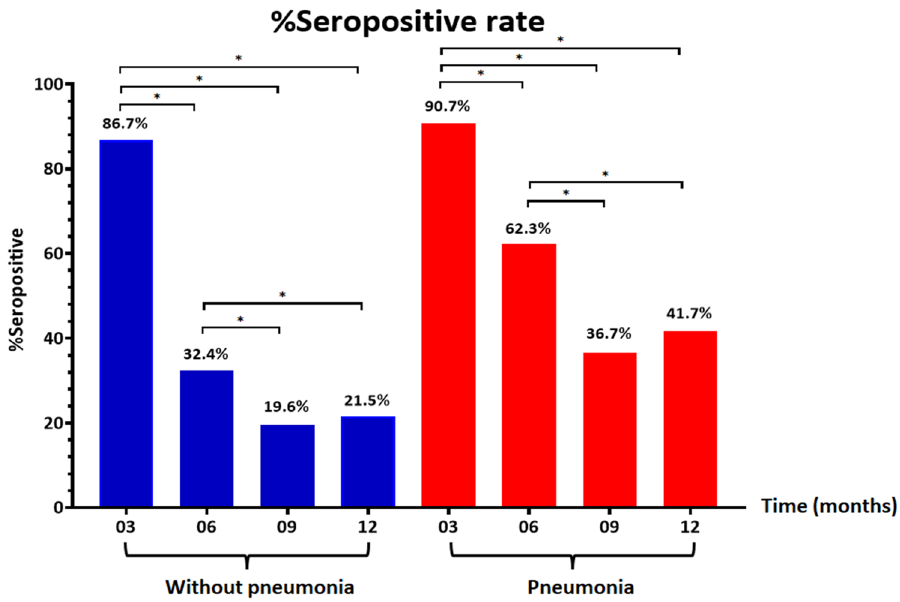
Figure 1. Seropositive rate of anti-nucleocapsid IgG among specimens at indicated time points after post symptom onset or first SARS-CoV-2 detection, stratified by disease severity. The cutoff was 1.4 S/C; S/C ≥ 1.4 was defined as positive and S/C < 1.4 as negative.